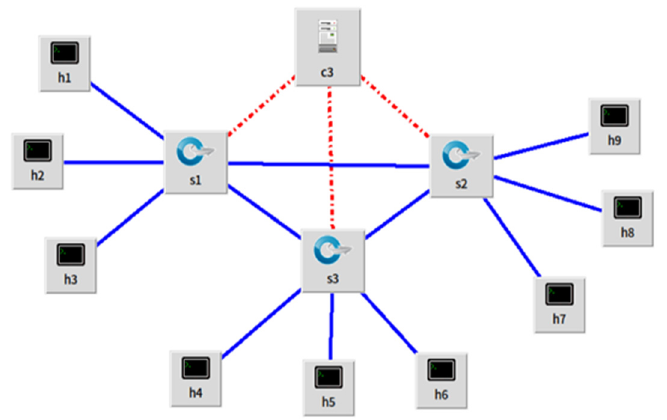
Figure 3. Designed network topology.